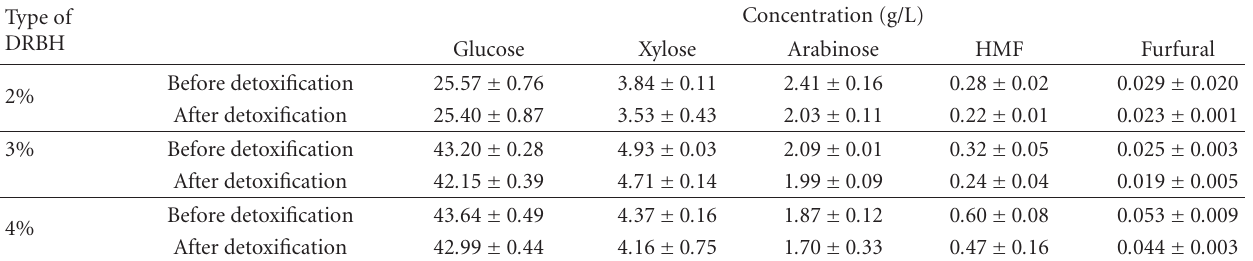
Table 2: Chemical composition of DRBH before and after detoxification. The hydrolysate used for detoxification was obtained by using 3% H 2 SO 4 at 90 ◦ C for 6 h.